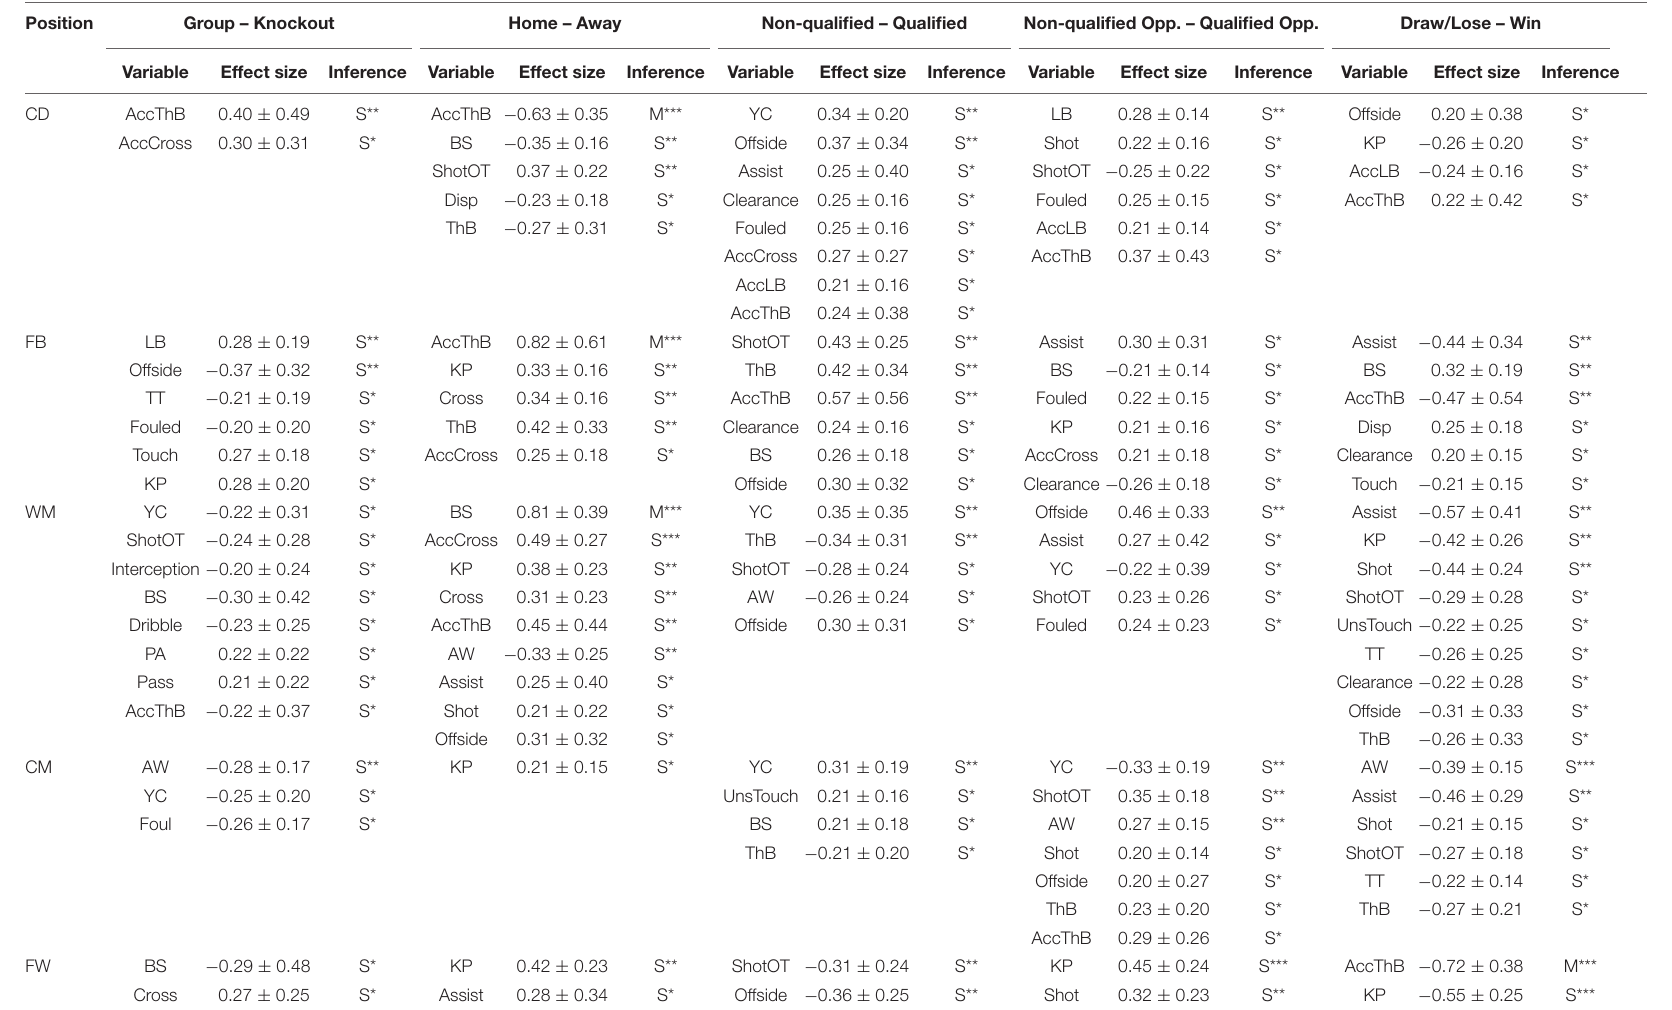
TABLE 2 | Substantial differences of players’ match performance variation across five playing positions and five competing situations.